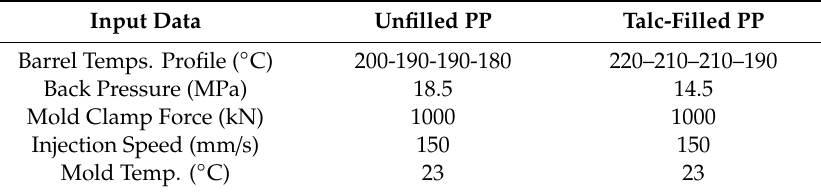
Table 3. Other major machine input